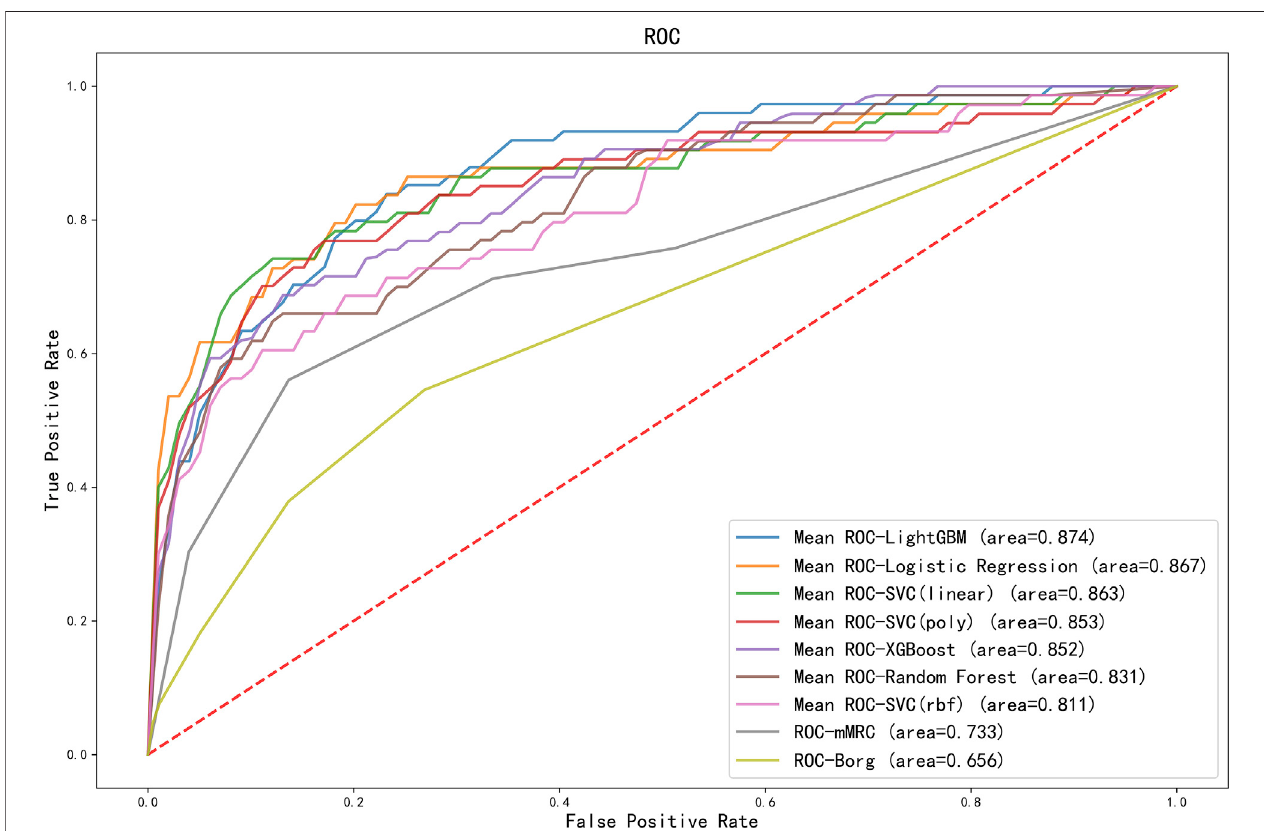
FIGURE 4 | ROC curves for different machine learning models and scoring scales. The ROC curves for machine learning models were the average score of the results of a fi ve-fold cross-validation. AUC results of all machine learning models outperformed the scales. SVC, support vector classi fi cation; LightGBM, light gradient boosting machine; XGBoost, extreme gradient boosting; mMRC, modi fi ed medical research council dyspnea scale.